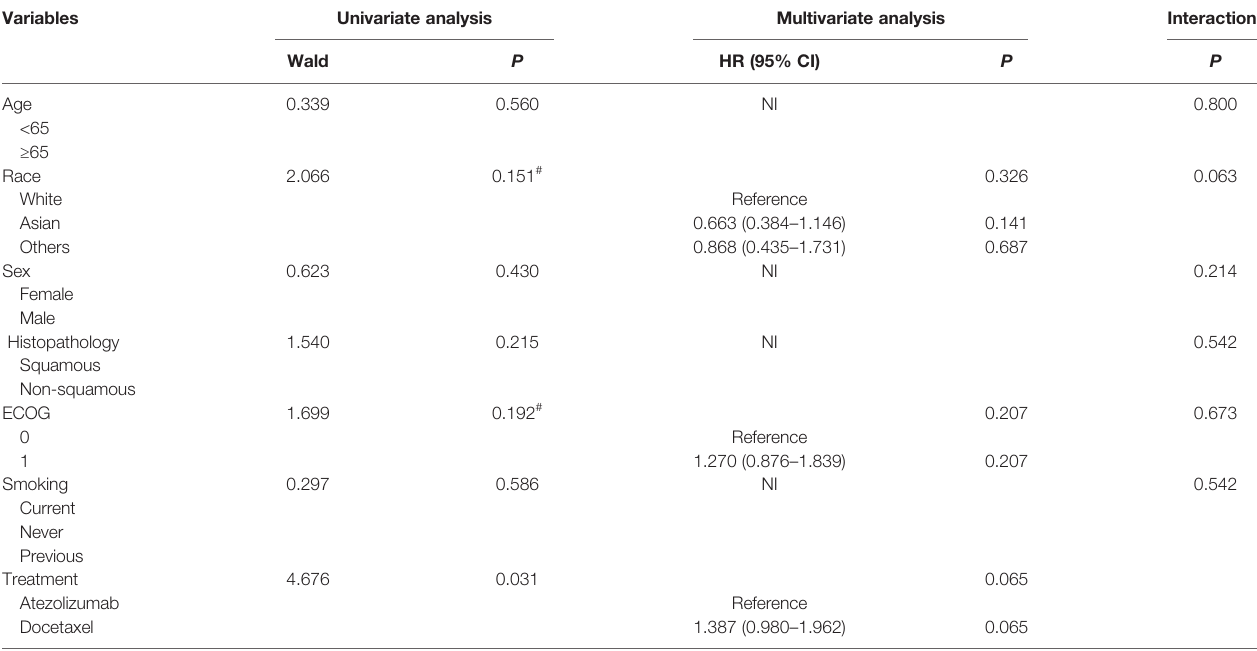
TABLE 3 | Univariate and multivariate Cox regression analysis of clinical variables affecting OS for high-risk patients based on training and testing